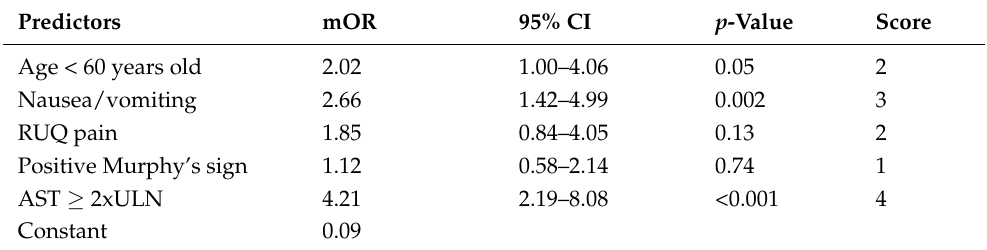
Table 3. A multivariable logistic model with score transformation via multivariable odds